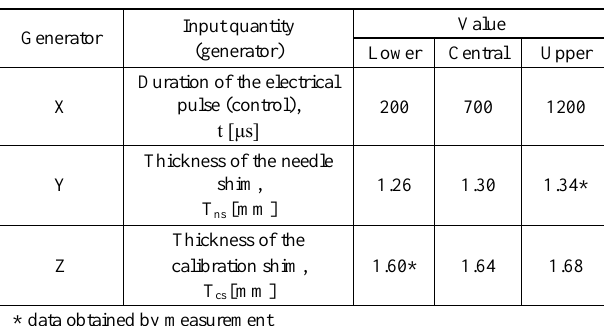
Table 4. Selection of input quantities in real